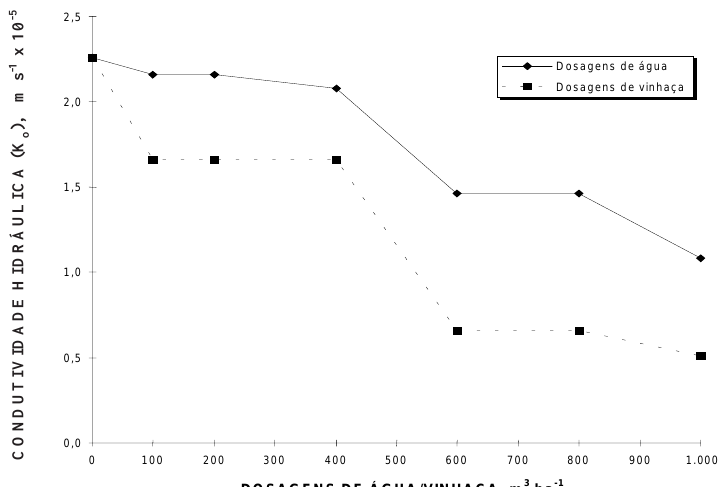
Figura 2. Condutividade hidráulica do solo saturado, K o , obtida pelos gráficos da taxa de infiltração versus tempo decorrido, em função das dosagens de água/vinhaça aplicadas em colunas de solo